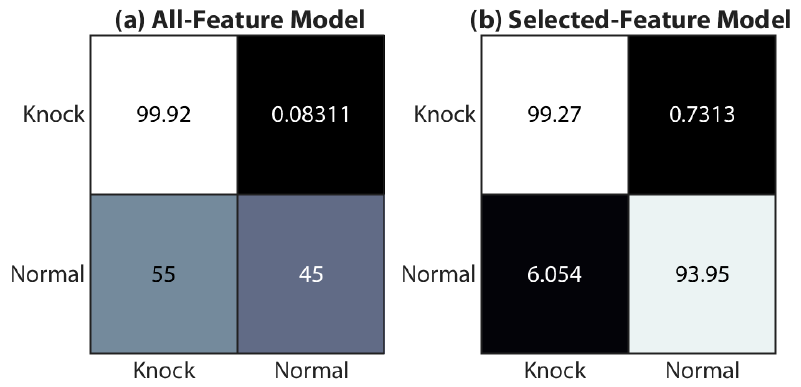
Figure 13. Classification accuracies of original and retrained models with the first experiment dataset.